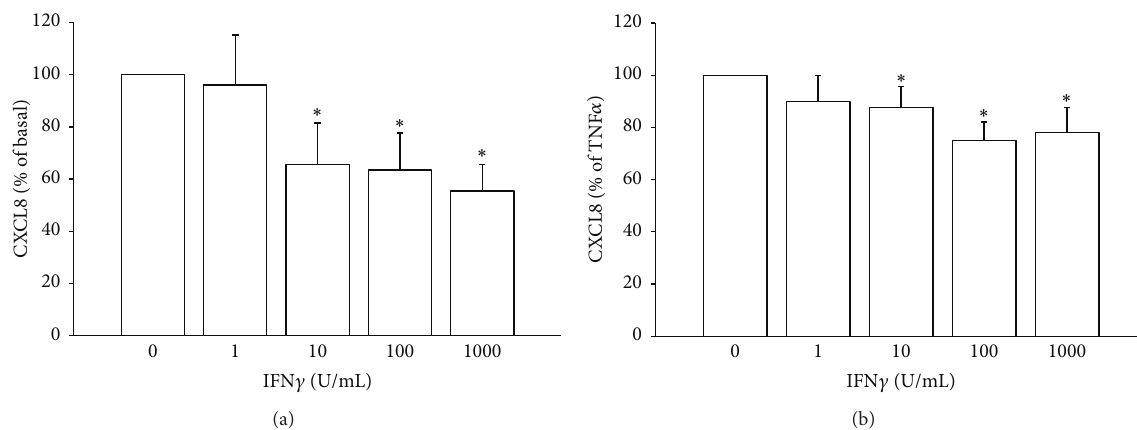
Figure 1: IFN 𝛾 inhibits the secretion of CXCL8 in BCPAP cells. (a) IFN 𝛾 significantly and dose-dependently inhibits the basal CXCL8 secretion (ANOVA F : 22.75; 𝑝 < 0.00001 ; post hoc analysis by Bonferroni: ∗ 𝑝 < 0.001 versus basal). (b) IFN 𝛾 significantly inhibits the TNF 𝛼 - stimulated CXCL8 secretion (ANOVA F : 15.30; 𝑝 < 0.00001 ; post hoc analysis by Bonferroni: ∗ 𝑝 < 0.001 and ∘ 𝑝 < 0.01 versus TNF 𝛼 ). The inhibitory effect of IFN 𝛾 is expressed as percentage of basal and TNF 𝛼 -induced levels of CXCL8, which were estimated as 100%.